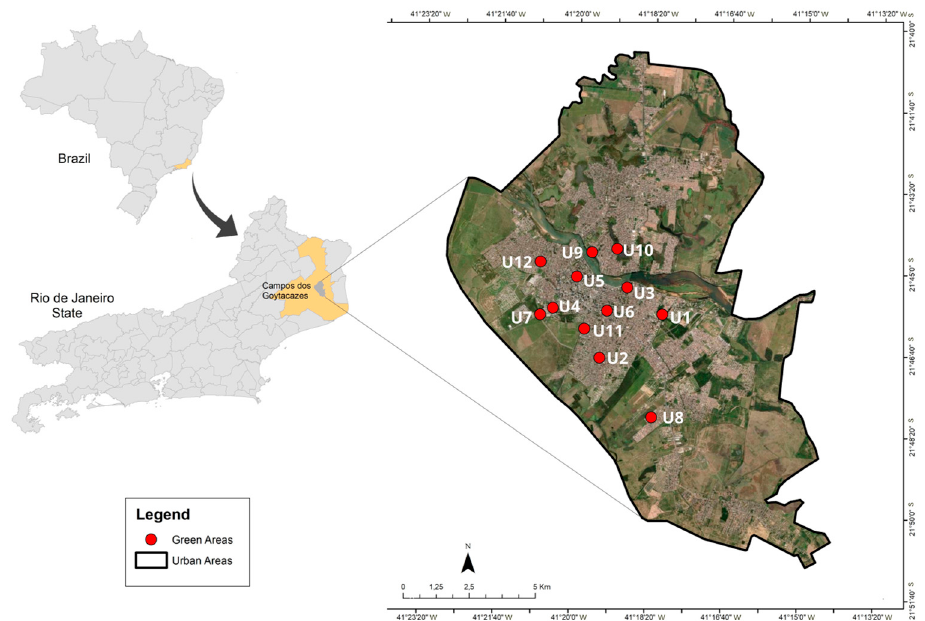
Figure 1. Red dots show the location of urban green areas (U1 to U12) evaluated in this study in the urban area of Campos dos Goytacazes, RJ, Brazil (Google image of the ArcGIS database).